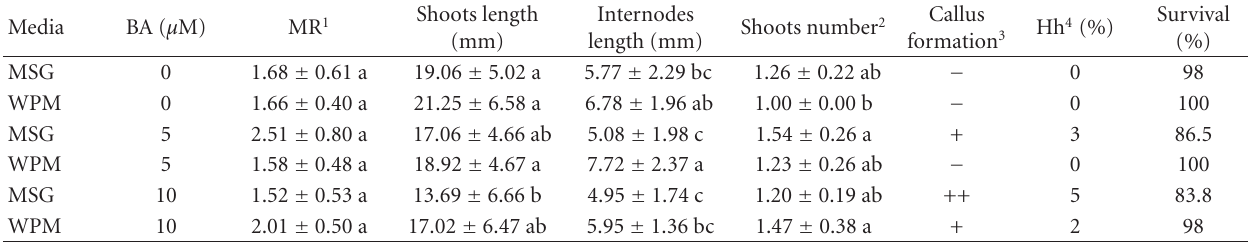
Table 2: E ff ect of di ff erent concentrations of benzylaminopurine (BA) on in vitro shoot multiplication of Handroanthus impetiginosus on MSG and WPM basic media after 30-day culture.